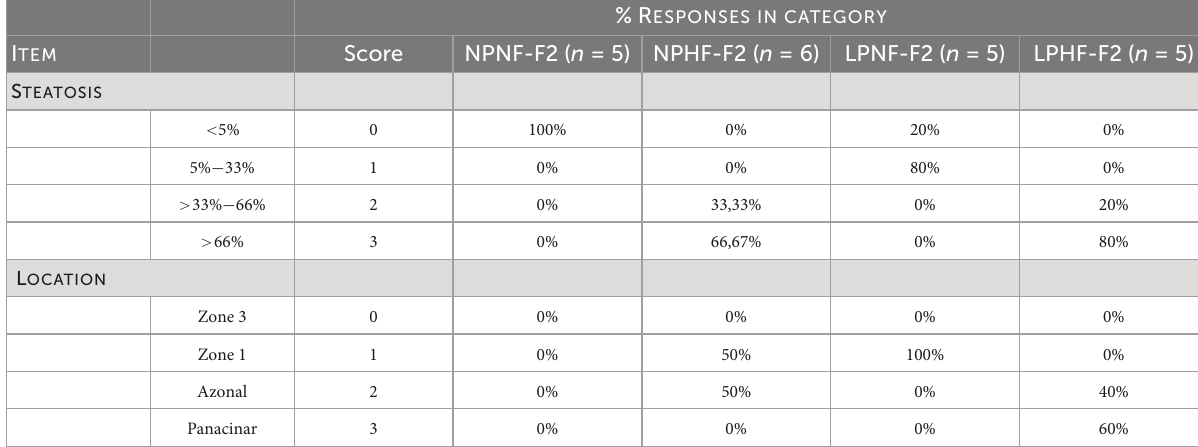
TABLE 2 Effect of HF consumption on hepatic steatosis of adult F2 offspring from dams programmed by protein restriction during